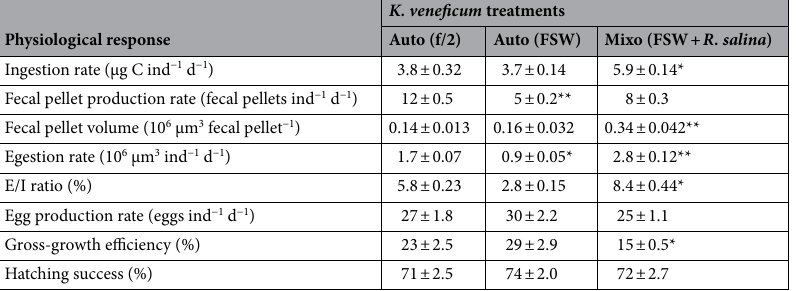
Table 2. Copepod physiological responses under the three K. veneficum diets. Auto autotrophic, Mixo mixotrophic, FSW plain filtered seawater. Significant comparisons are indicated by *. * P < 0.05, ** P < 0.001. Average ± 1